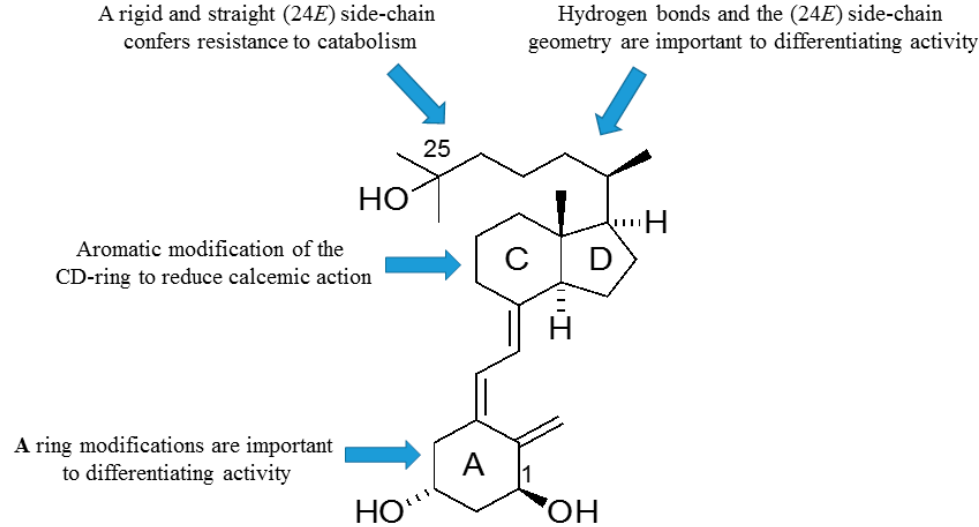
Figure 6. Map of the relationships between structural modifications to 1 α ,25-dihydroxyvitamin D 2 and biological actions.